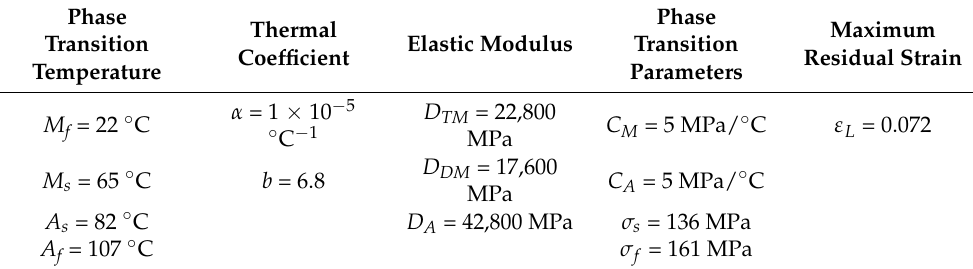
Table 1. The transformation temperatures and thermomechanical properties of